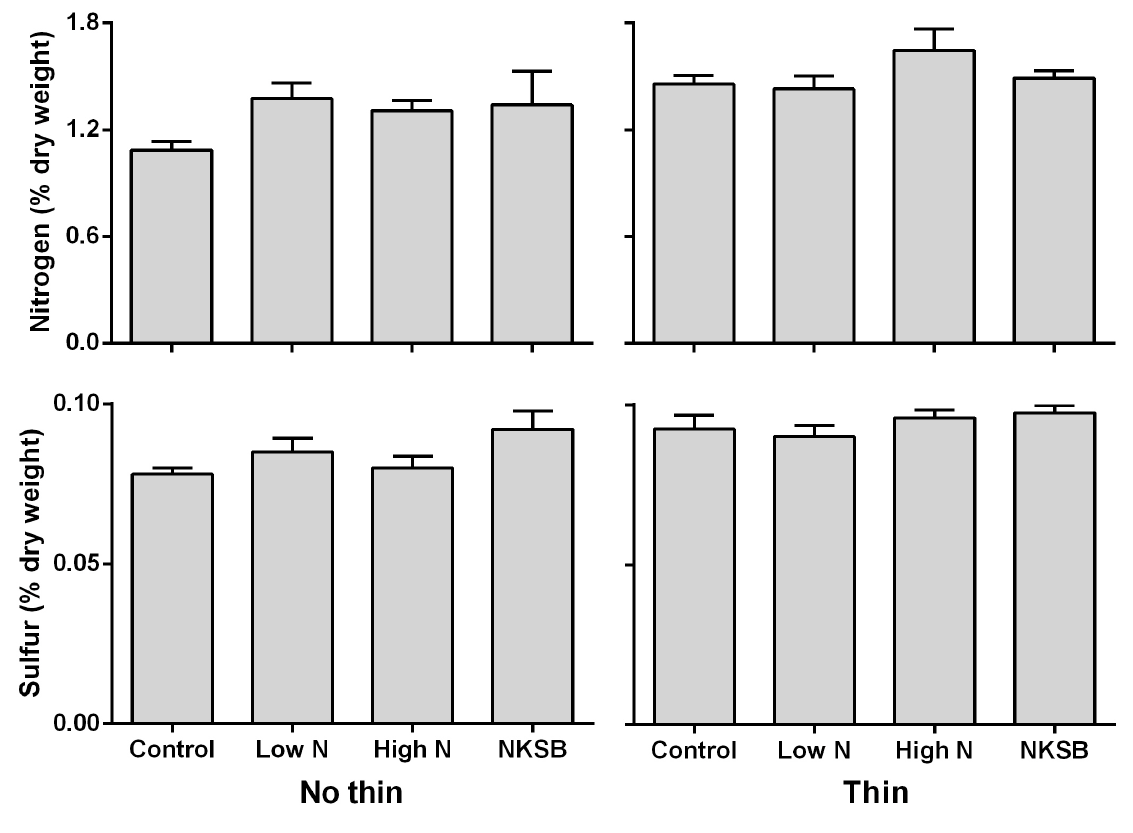
Figure 3. Nitrogen and Sulfur content (% ± SEM) of the current year’s foliage following thinning and fertilization (Con = control, Low N = 227 kg N/ha, High N = 454 kg N/ha and Compl = low N + K + S + B) treatments the prior